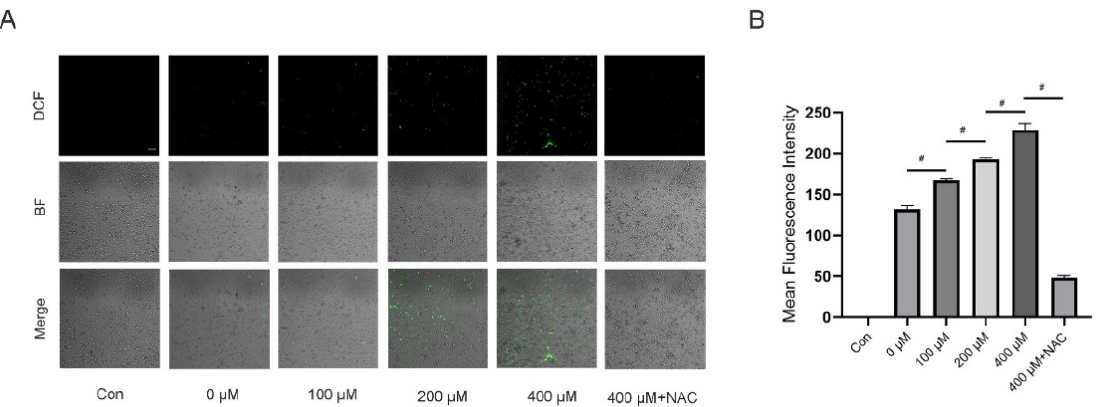
Figure 5. TMAO increased ROS levels in BMMs during osteoclast differentiation. ( A ) Representative confocal images of intracellular ROS generation. Scale bar = 100 µ m. ( B ) BMMs were stimulated with or without RANKL for 3 days and then probed with 10 µ M DCFH-DA for 30 min after being treated with different concentrations of TMAO. TMAO treatment led to increased fluorescence intensity of ROS in BMMs in a dose-dependent manner, and NAC treatment decreased TMAO-induced ROS generation ( n = 3 per group). # p < 0.01.